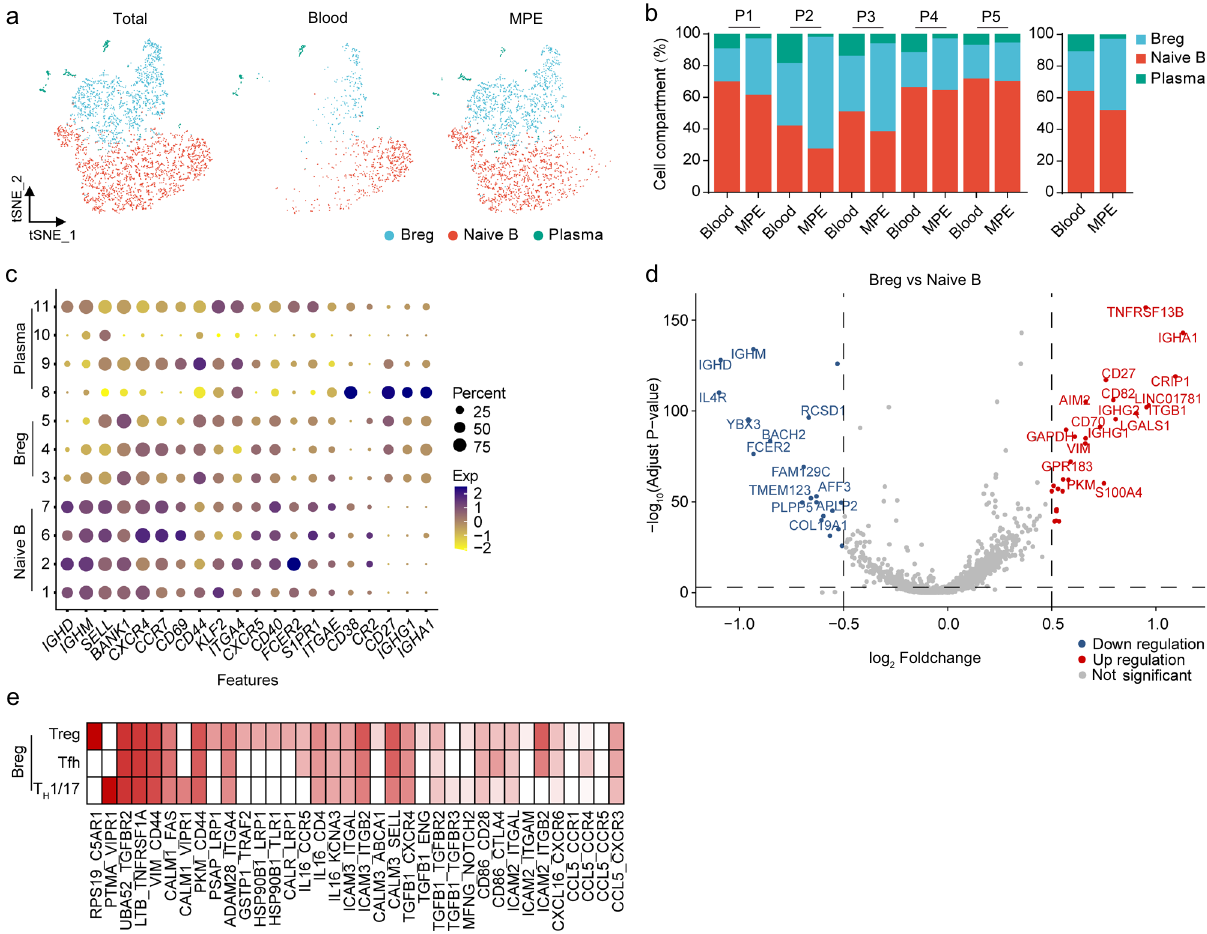
Fig. 3 Dissection and clustering of B cells in MPE patients. a t-SNE plots of B cells within each cell type, color-coded by B cell subsets. b Average proportion of each cell subset derived from each patient (left panel) and MPE or blood (right panel). c Dot plot of the average expression of canonical marker genes for B cells. Y -axis: Seurat-clusters in Supplementary Fig. 3a. d Scatter plot of differentially expressed genes of the Breg cells in comparison with naive B cells in MPE. e Heatmap of cell-to-cell interaction scores between Breg cells and Th1/17 cells, Treg cells, or Tfh